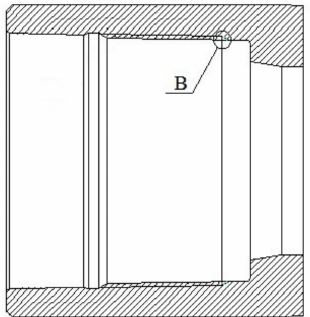
Figure 3. Temperature measurement point of steel joint.